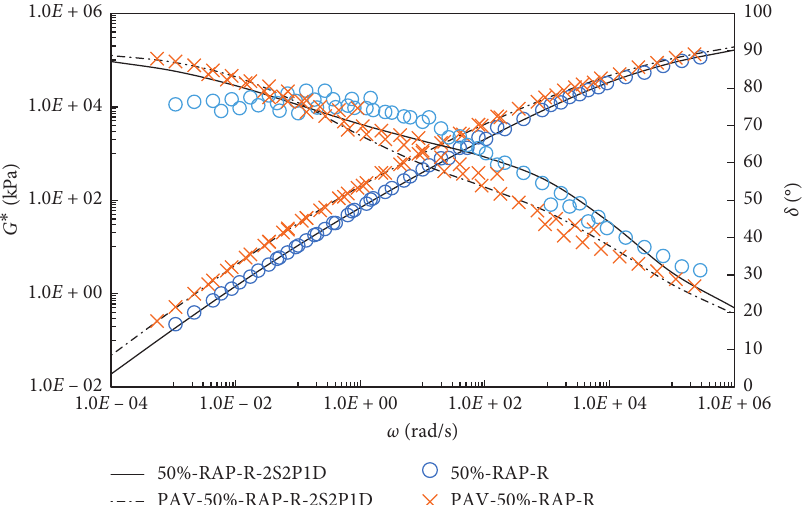
Figure 12: Complex shear modulus and phase angles master curves for RAP-R binder containing 50% RAP binder before and after PAV